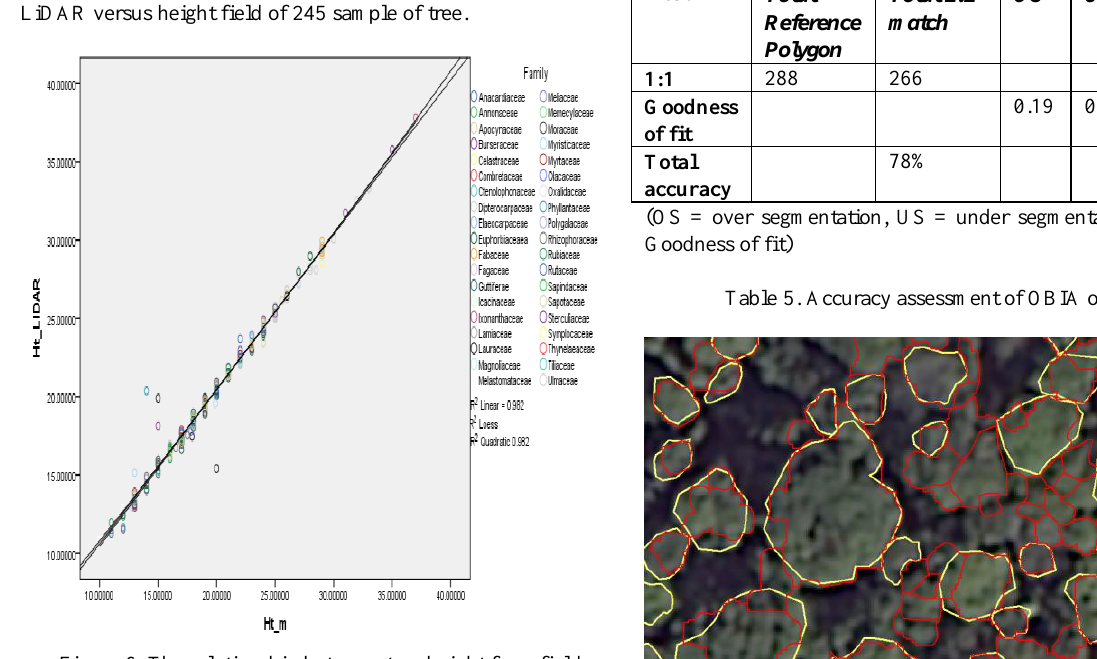
Figure 6. The relationship between tree height from field (Ht_m) and tree height derived from LiDAR (Ht_LIDAR).